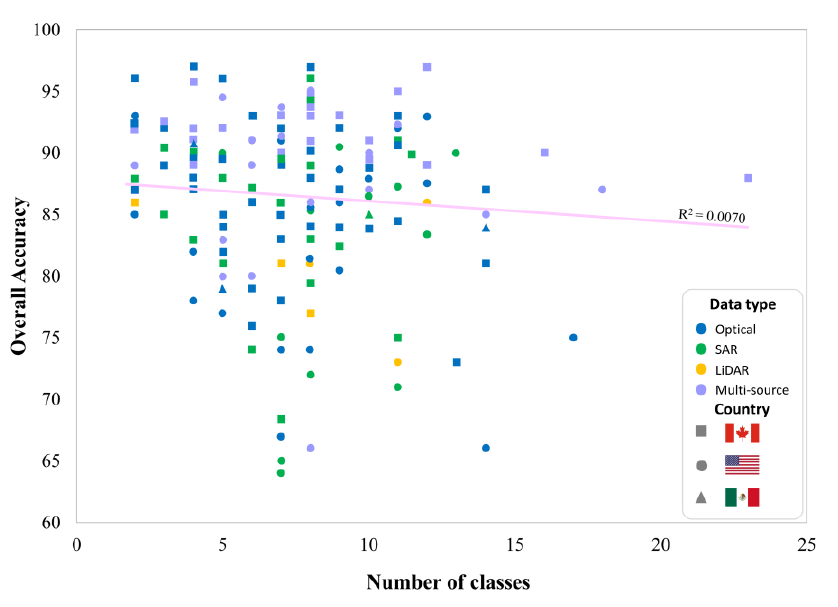
Figure 18. Correlation of overall accuracy and number of wetland classes in the final map. 503